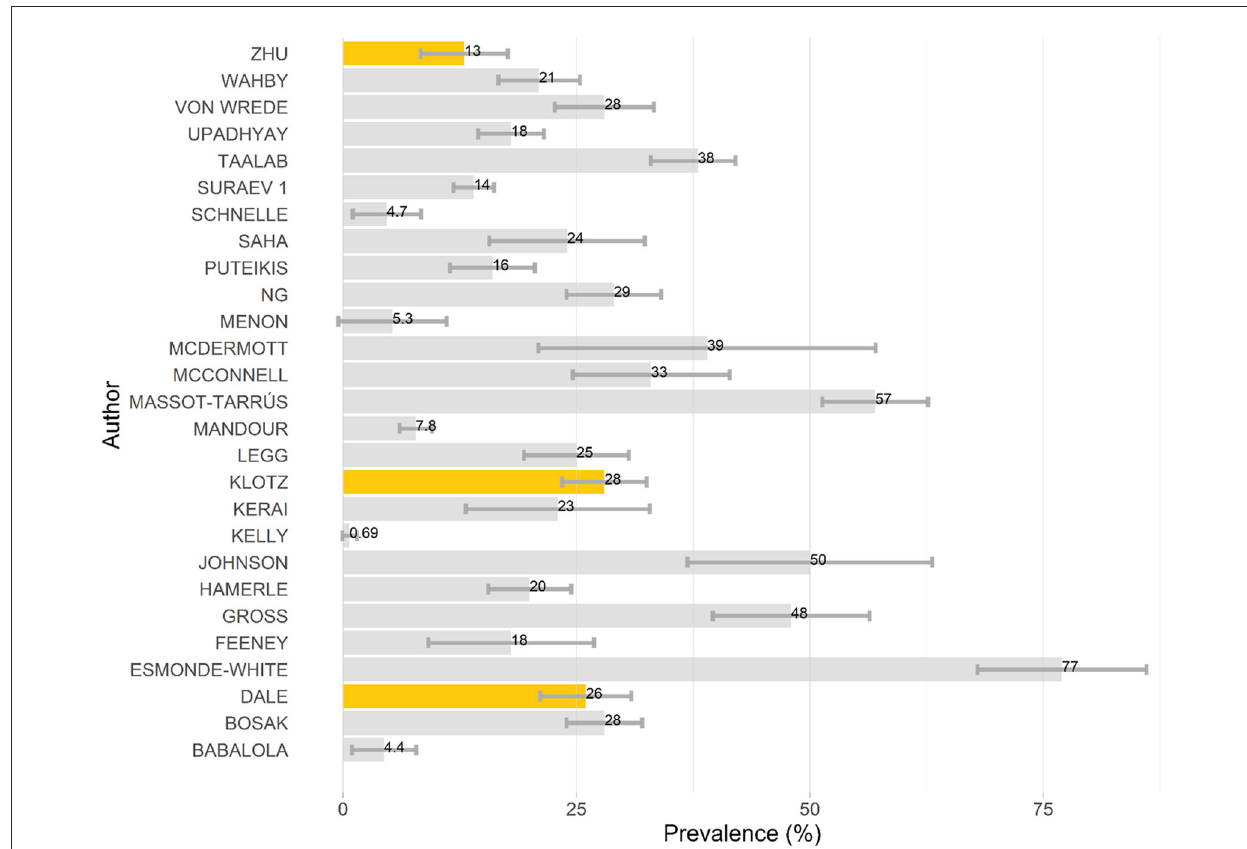
FIGURE3 Lifetime prevalence of NMC use in PWE. This barchart presents the lifetime prevalence of NMC use in PWE for each publication for which this information was available. Gray bars represent prevalence calculated from adult samples, whereas orange bars represent prevalence calculated from pediatric samples. Confidence intervals are provided, as calculated using an α -error of